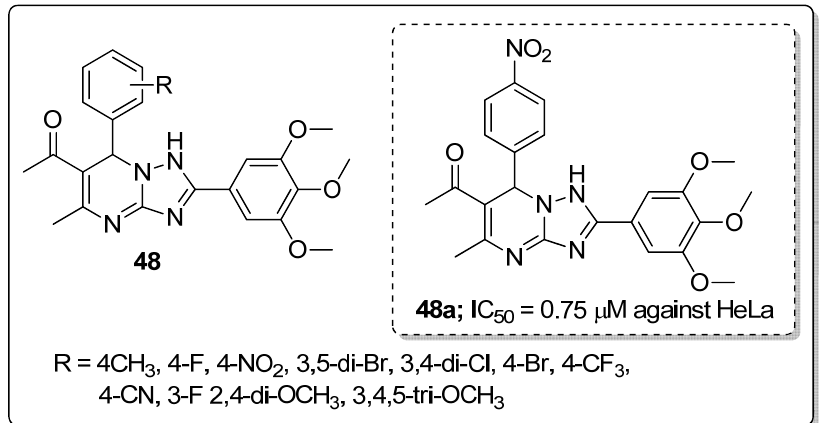
Figure 55. Antiproliferative activity of the most active 1,2,4 ‐ triazole ‐ pyrimidine hybrid 48a